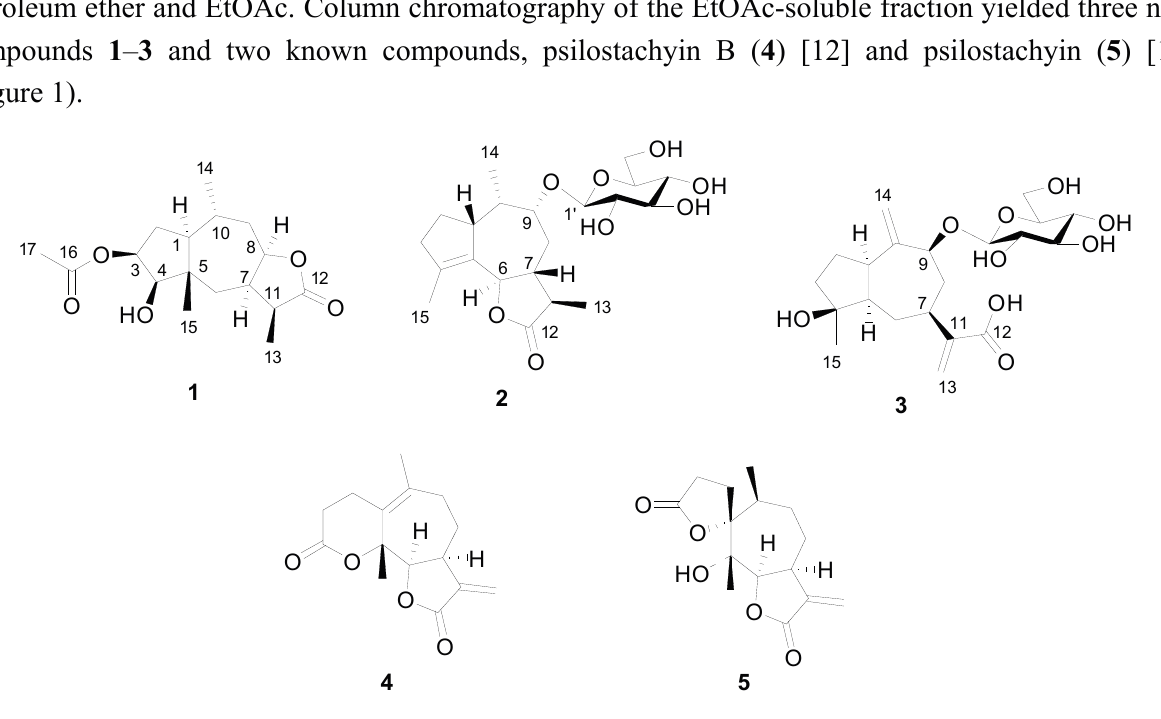
Figure 1. Structures of compounds 1 – 5 isolated from A. artemisiifolia